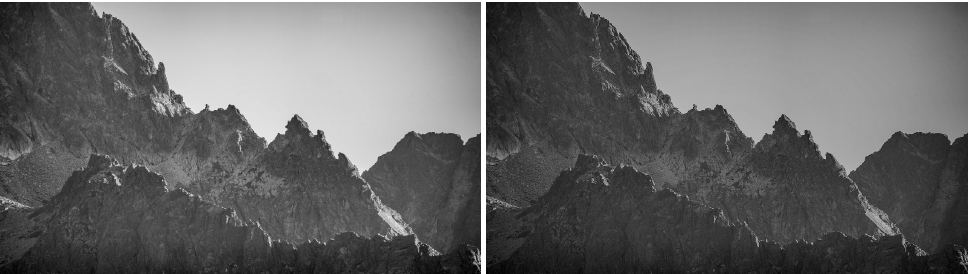
Figure 18. Comparison of output images obtained without ( left ) and with ( right ) a Laplace filter on the input